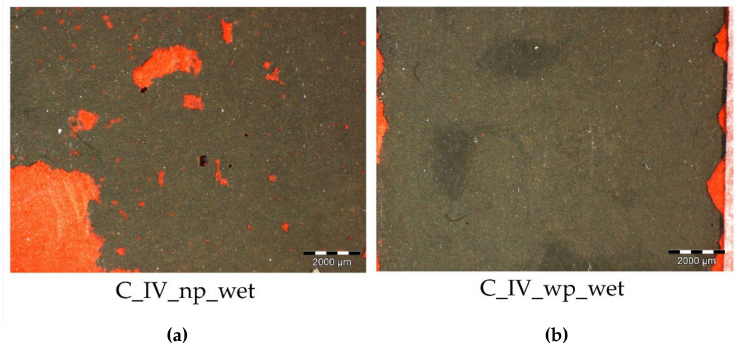
Figure 10. Optical images at 10 × of mock-up C treated with laser at 7 Hz frequency and fluence of approximately 4.14 J / cm 2 on unprotected (np) and protected (wp) area. ( a ) C_IV_np_wet; ( b ) C_IV_wp_wet.